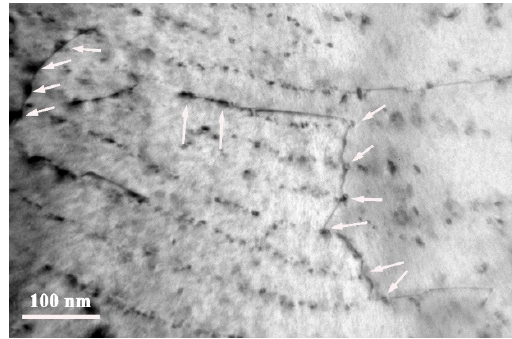
Figure 9. TEM micrographs of dislocations and precipitates in steel LC600+600T.